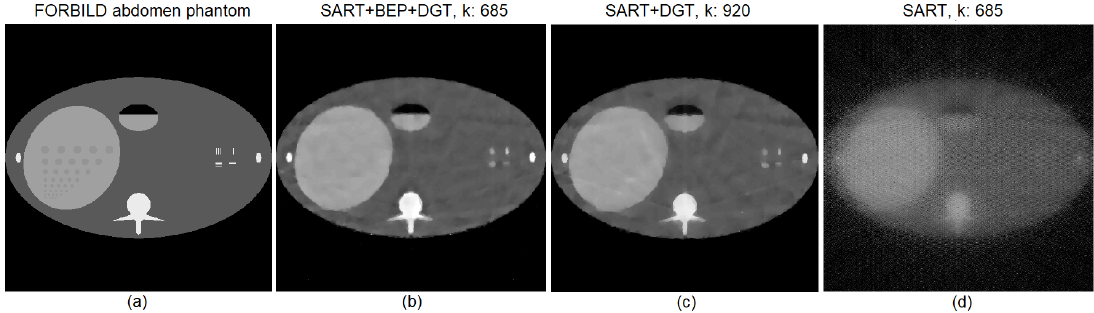
Figure 10. ( a ) The original FORBILD abdomen phantom and particular reconstructions for 15 projections ( b ) from SART+BEP+DGT with k = 685 steps, PSNR: 77.7180, SSIM: 0.9419, ( c ) from SART+DGT with k = 920 steps, PSNR: 77.7197, SSIM: 0.9397, and ( d ) pure SART with k = 685 steps, PSNR: 66.0972, SSIM: 0.0946.